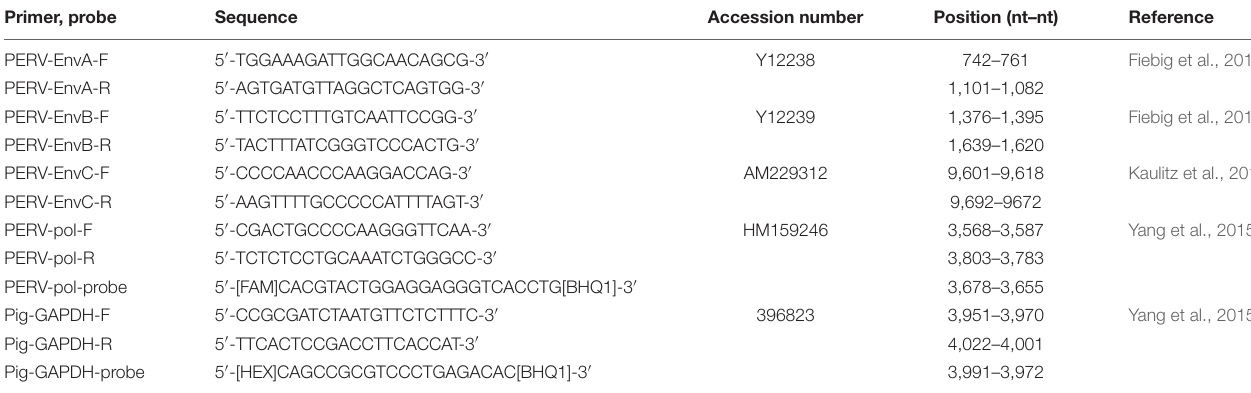
TABLE 1 | Primers and probes for PERV